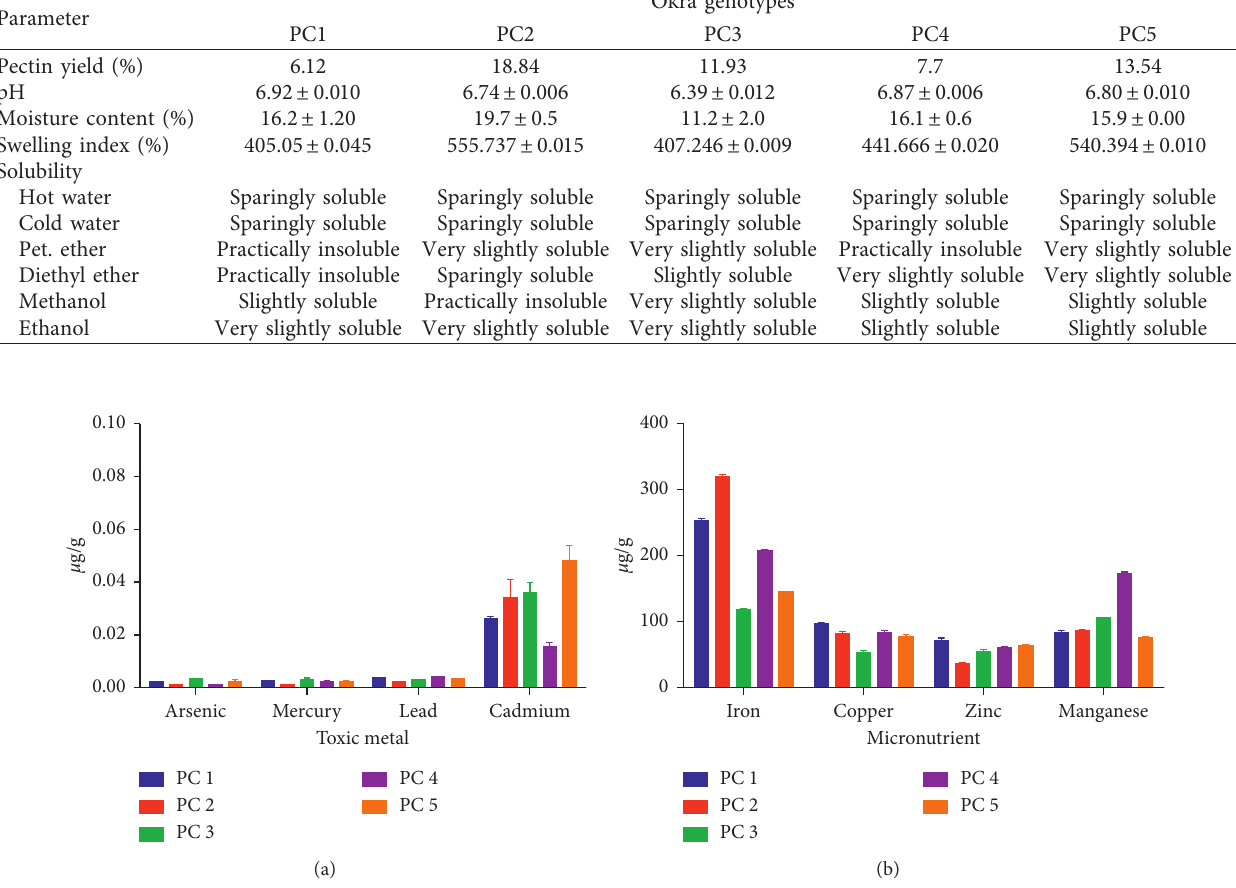
Figure 1: Elemental analysis on pectin from various genotypes; (a) toxic metals and (b) micronutrients.